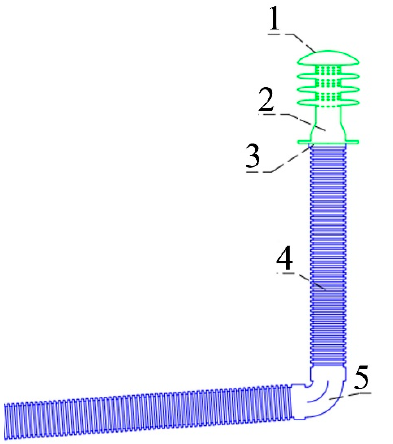
Figure 1. Details of the air intake.